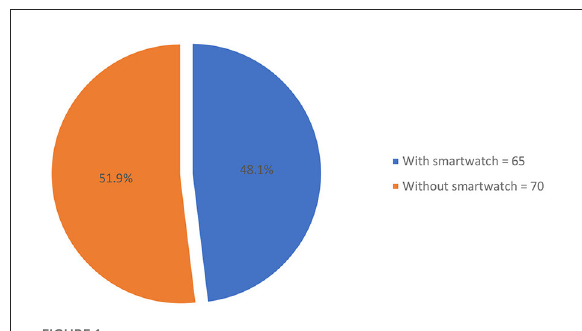
FIGURE1 Prevalence of participants who own